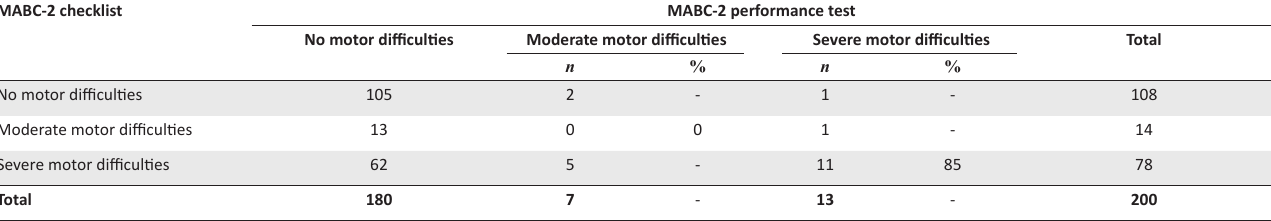
TABLE 4: Inter-rater agreement between the movement assessment battery for children - second edition performance test and the movement assessment battery for children - second edition checklist with the three cut-off scores. MABC-2